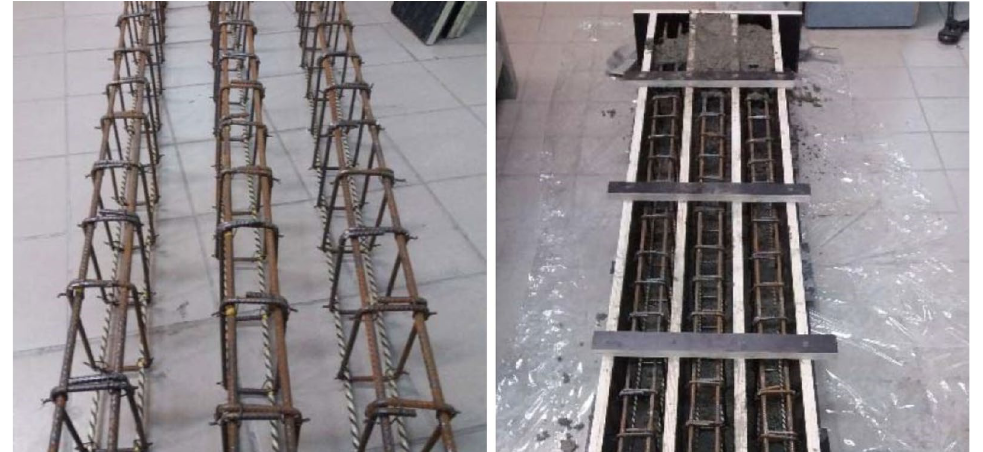
Fig. 7 Reinforced concrete beam